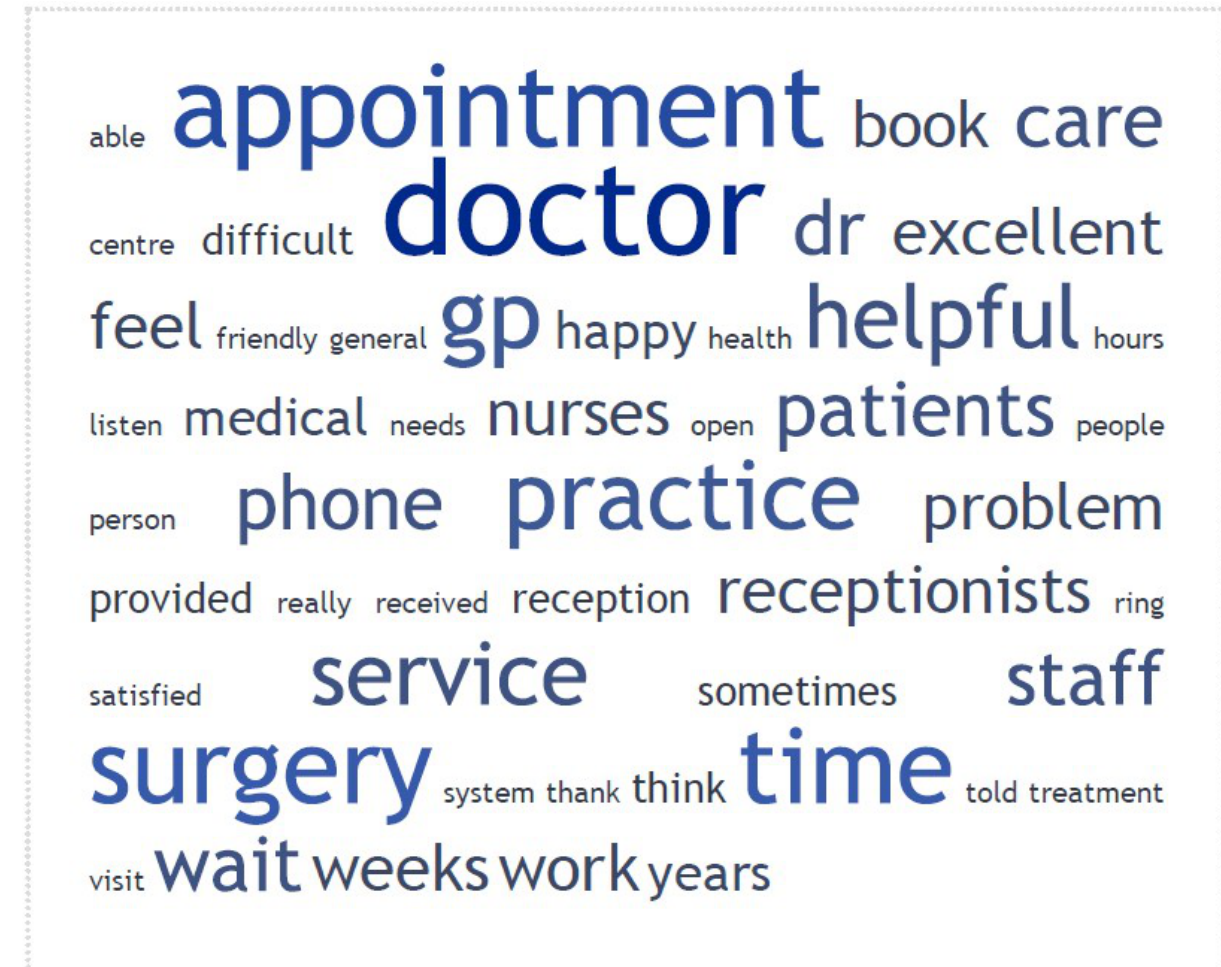
Figure 1. Single-word text cloud created in TagCrowd from all free text